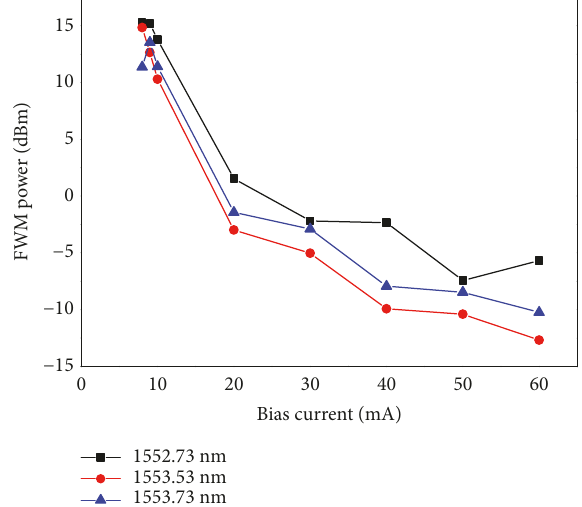
Figure 5: Optical power-to-bias current curves for FWM products near the operating wavelengths of master(s) and slave